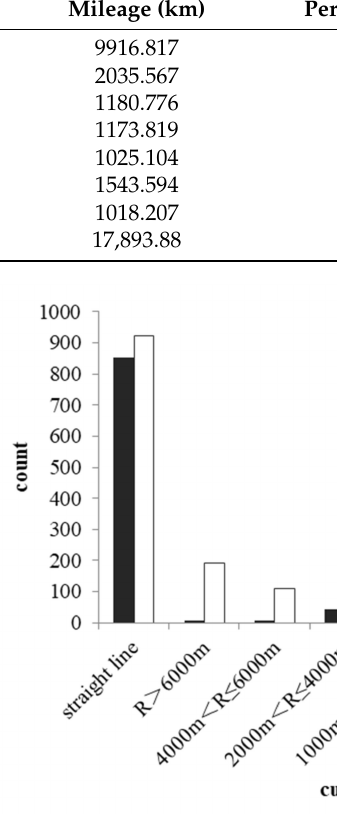
Figure 4. Plot of observed and expected accident occurrence with different curve